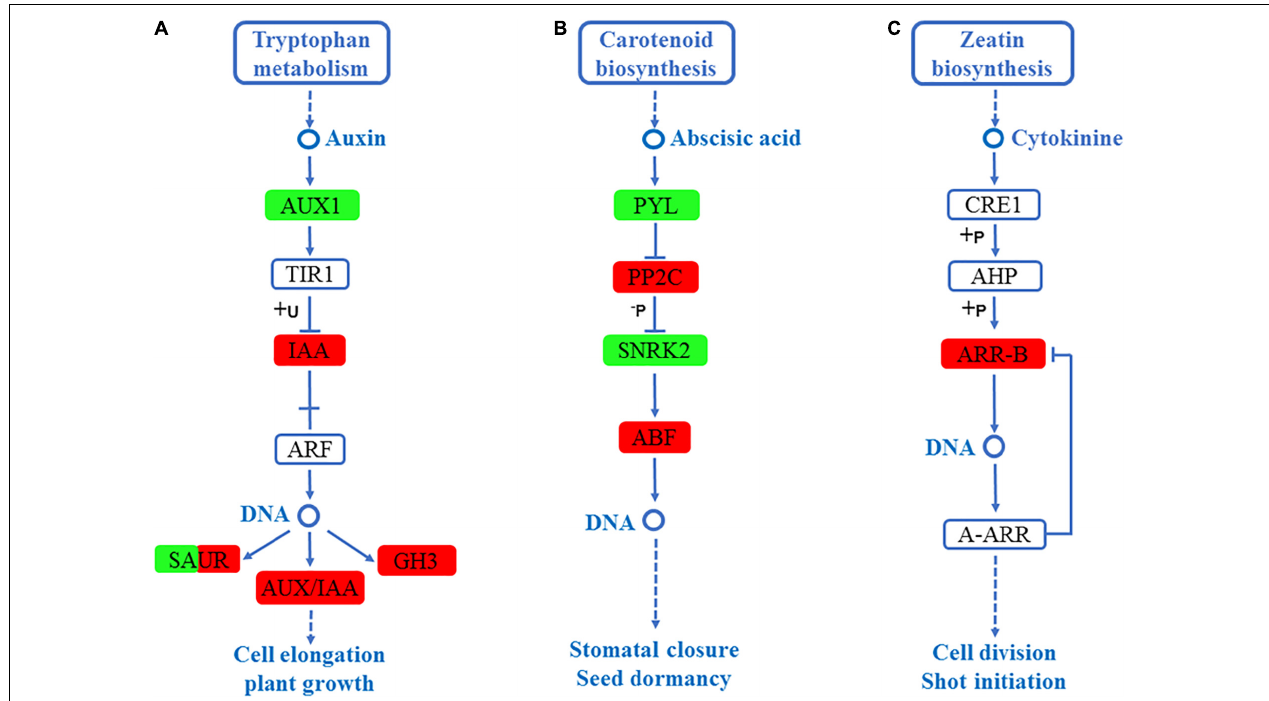
FIGURE 6 | DEGs mapped to the plant hormone signaling transduction pathways in the roots of S. argel plants under salt stress conditions. (A) Auxin signaling pathway, (B) ABA signaling pathway, and (C) Cytokinin signaling pathway. The red box indicates up-regulated compared with the control. At the same time, the green box indicates down-regulated compared with the control: the fold change (FC) and P -value ≤ 0.05 are shown in Table 2